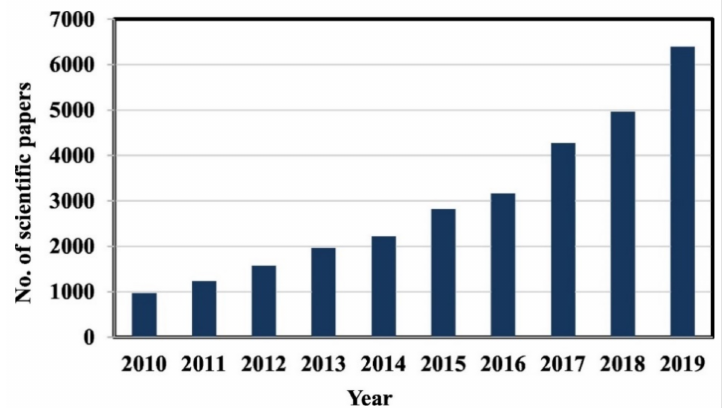
Figure 1. A graphical representation of data published on geopolymers from 2010 to 2020 based on its economical and energy consumption benefits. Reprinted with permission from Ref. [2]. Copyright 2021, with permission from